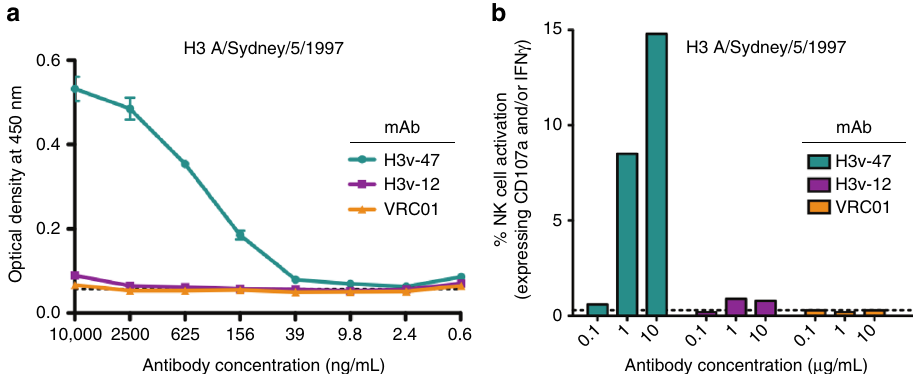
Fig. 6 H3v-47 mAb exhibits ADCC activity. a Cross-linking of Fc γ RIIIa. Binding curves were obtained by performing ELISA with serial dilutions of each antibody (H3v-47, H3v-12, or control mAb VRC01 [to HIV]) onto HA-coated plates and assessing the ability of HA-bound mAbs to engage both Fc-binding sites on the soluble Fc γ RIIIa dimer. b Primary NK cell activation. Antibody (H3v-47, H3v-12, or VRC01) at 0.1, 1, or 10 µ g/mL each were added independently on 96-well plates coated with puri fi ed A/Sydney/5/1997 H3 HA and incubated for 2 h. The plates were washed, and 5 × 10 5 puri fi ed NK cells were added to each well. The cells were stained with anti-human CD107a allophycocyanin-H7 Ab, anti-human CD3 PerCP, anti-human CD56 allophycocyanin, and anti-IFN γ AF700. The data for 20,000 – 50,000 events were acquired using an LSRFortessa fl ow cytometer. The percentage of NK cell activation was calculated as the percentage of NK cells that expressed CD107a and/or IFN γ . The dotted lines in both a and b indicate the limit of detection. The results are representative of three independent experiments. Error bars indicate standard error of the mean